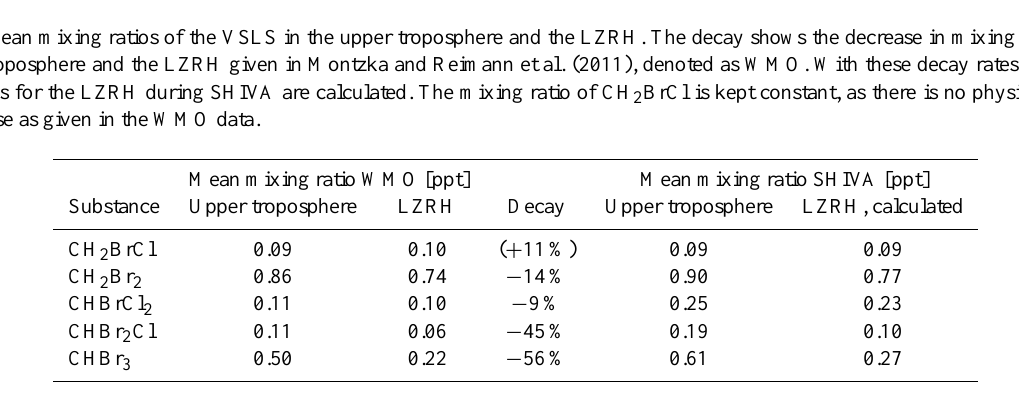
Table 12. Budget of total organic bromine at the LZRH with the contribution of different substance classes. The VSLS value for the SHIVA campaign is calculated from the estimate described in Table 11 using the decay in mixing ratio between UT and LZRH. The values given for SHIVA are (mean mixing ratio ± measurement uncertainty). The measurement uncertainty is the sum of scale accuracy and instrumental measurement precision. The global average values (see also Tables 7 and 9) are from Montzka et al. (2003) 1 (updated) and Newland et al. (2013) 2 (for H-1202), and Montzka and Reimann et al. (2011) 3 . The values given for Teresina are from Brinckmann et al. (2012) 4 and Laube et al. (2008). Low VSLS values ( ∗ ) found in Teresina (2005) are most probably due to sample loss in the canisters caused by the long period which elapsed between sampling and analysis of the air